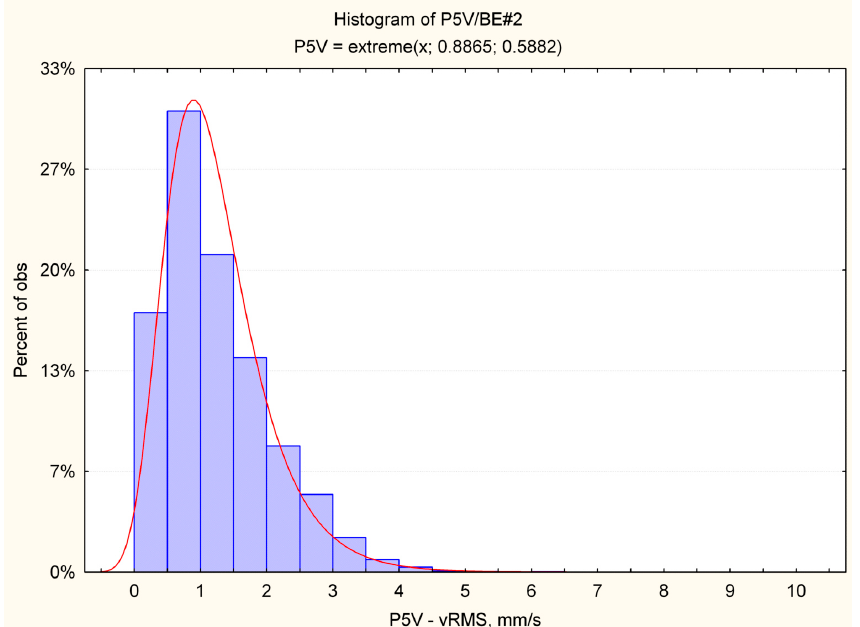
Figure 16. Histogram of vibration velocity v RMS and the estimated Gumbel Extreme Value model for point P5 (in the vertical direction) in bucket elevator